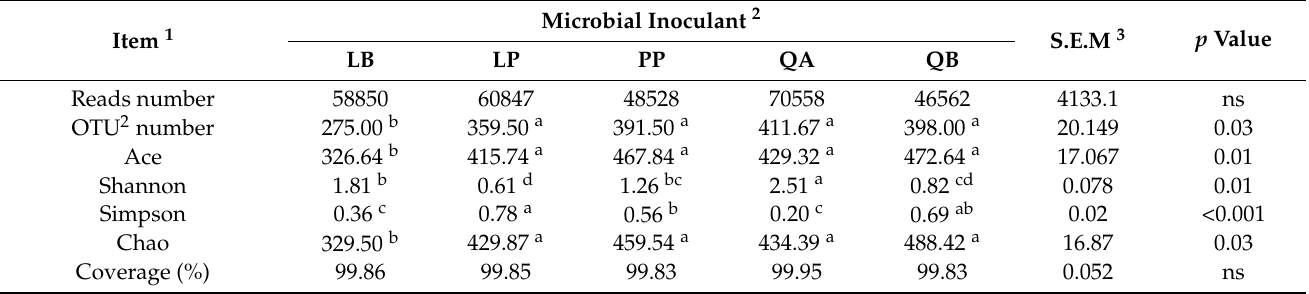
Table 4. The α diversity of bacterial communities of different LAB in whole corn silage after 60 days ensiling.